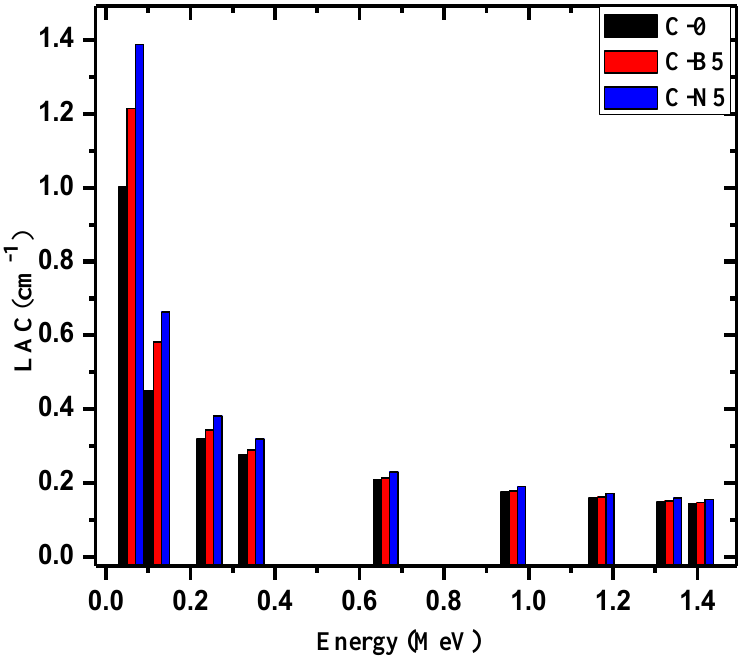
0.0 Figure 4. The linear attenuation coefficient for the C-0, C-B5 and C-N5. Figure 5 analyzes the influence of nanoparticle Bi 2 O 3 on the LAC of the concretes. Samples with 5, 10, and 15% Bi 2 O 3 were selected to observe the effect of increasing the nanoparticle Bi 2 O 3 concentration on the shielding ability of the concretes. At all energies, the LAC values have the trend of C-N5 < C-N10 < C-N15. At 0.245 MeV, for instance, the LAC values increased from 0.381 to 0.418 and 0.472 cm − 1 for C-N5, C-N10, and C-N15, respectively. These results demonstrate that increasing the amount of nanoparticle Bi 2 O 3 improves the shielding ability of the concrete. Furthermore, the influence of Bi 2 O 3 on the LAC values is clearer at low energies. For example, at 0.0595 MeV, C-N5 (cid:48) s LAC was 1.39 cm − 1 , C-N10 (cid:48) s LAC was 1.70 cm − 1 , and C-N15 (cid:48) s LAC was 2.11 cm − 1 . This trend can be understood according to the domination of photoelectric process. At higher energies, meanwhile, the effect of Bi 2 O 3 on the shielding ability of the concretes is minimal, and the difference between their capabilities of the samples is small. This is a result of the domination of Compton scattering which has a weak dependence on the chemical composition of the medium. The LAC values at 1.41 MeV are equal to 0.155, 0.158, and 0.164 cm − 1 for C-N5, C-N10, and C-N15, respectively. Nevertheless, at all energies, the C-N15 sample had the greatest LAC out of these three